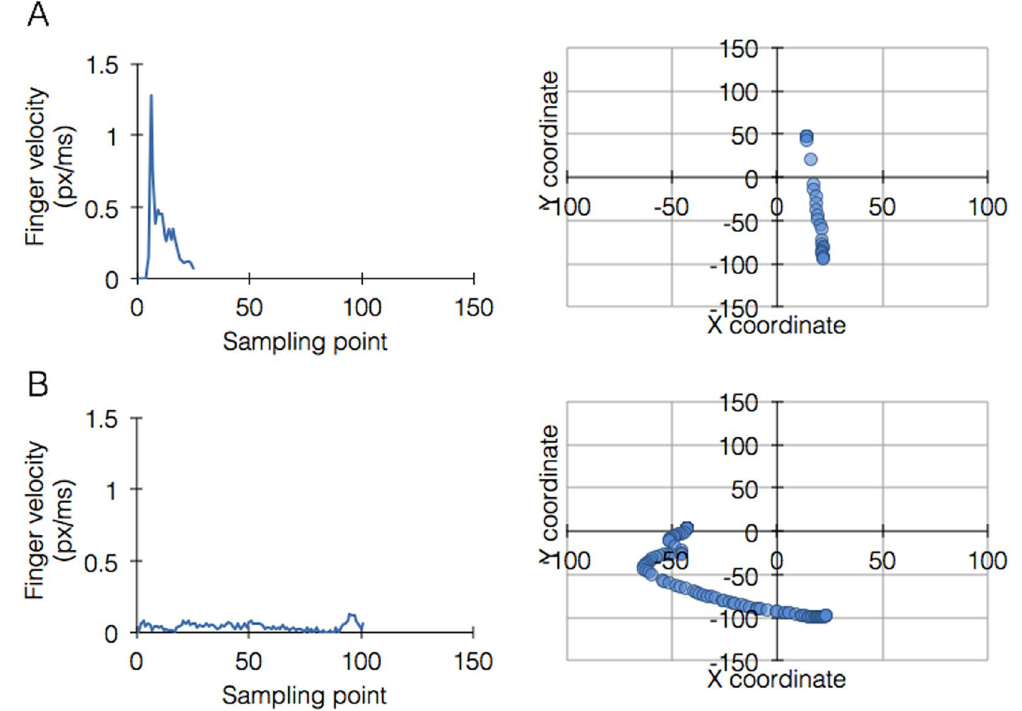
Figure 4. Metadata analyses showing differential finger performance. Representative single finger trace data from a complex gesture (in this case 4 finger scale). ( A ) Finger performing as normally expected: fewer high velocity data points at impact with screen, relieving towards the end with many slower data points at the end. ( B ) stiff finger showing a significantly longer gesturing time, uniform low velocity throughout and uniform distribution of data